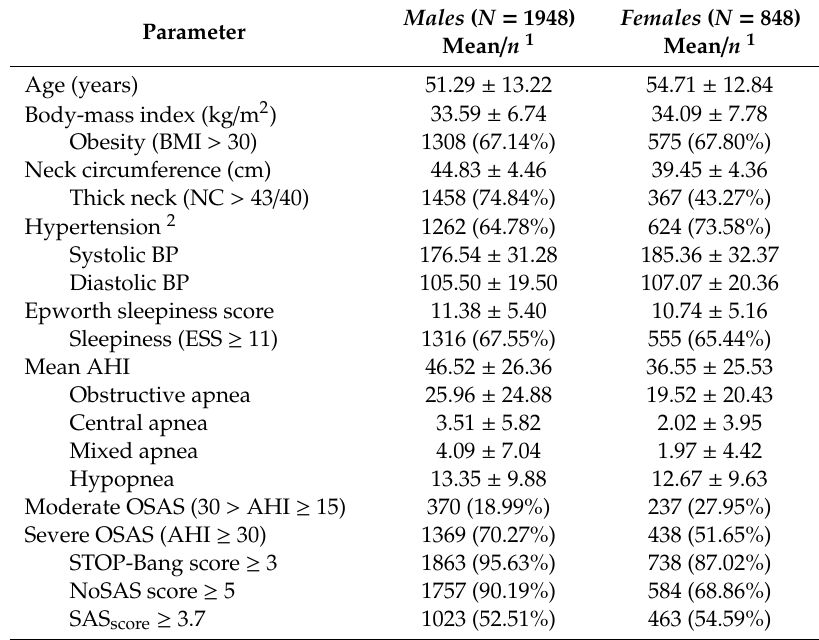
Table 1. The WestRo patient cohort, with a total of N = 2796 patients, divided into male and female cohorts; we present the synthesis of anthropometric data, clinical parameters, as well as the moderate and severe OSAS prevalence.